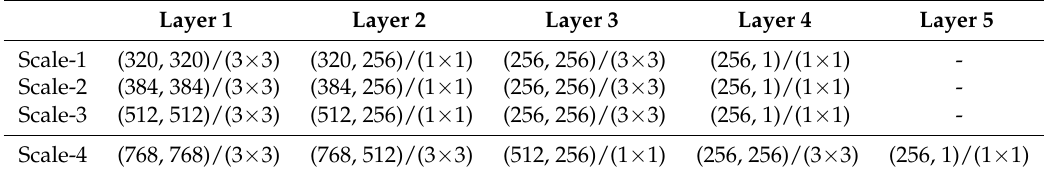
Table 1. Detail architectures of the proposed network. ( m , n ) / ( k × k ) means that there are m channels in previous layer and n channels in current layer; the filters connecting them have size k × k . Scale-4 architecture is slightly different to the other three ones in that it has one additional convolutional